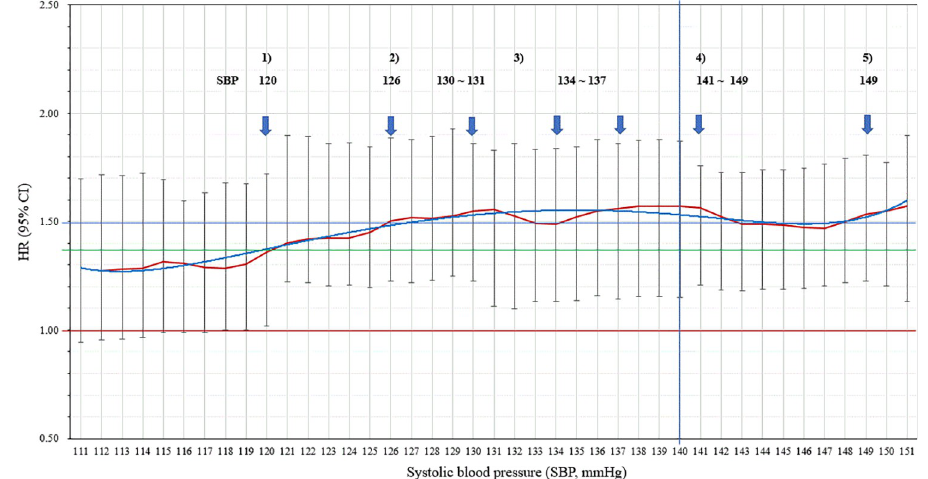
Fig 1. The risk trend of cardiovascular mortality according to each specific systolic blood pressure (SBP) level.